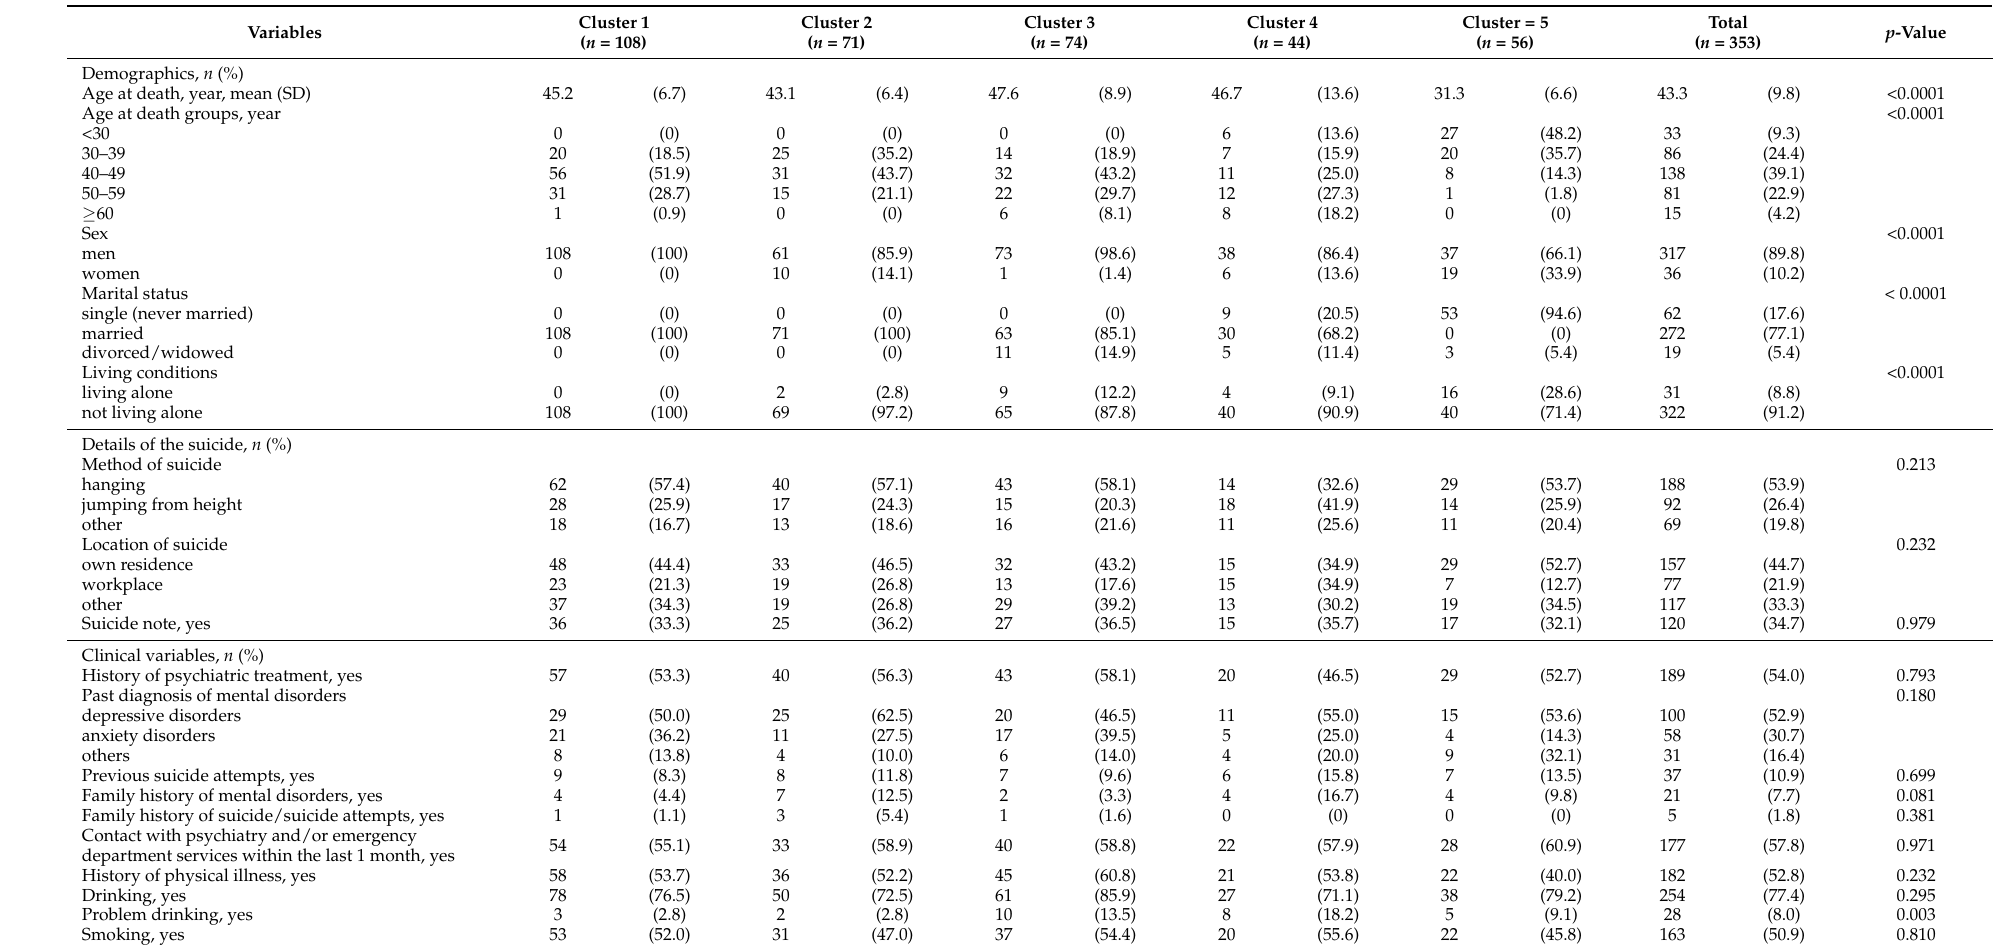
Table 1. Comparison of demographic, suicide details, and clinical variables for five clusters of worker suicide